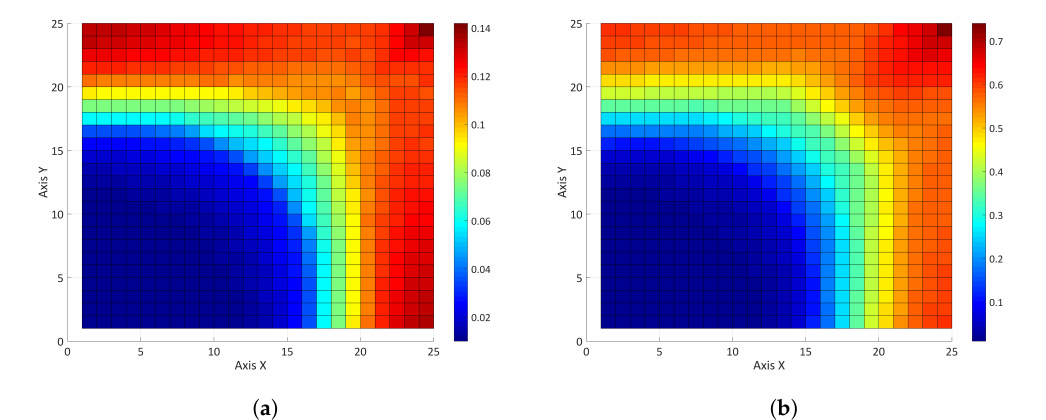
Figure 18. Partition coefficient after 1000 days with initial salt content of 0.5% ( a ) and 2.5% ( b